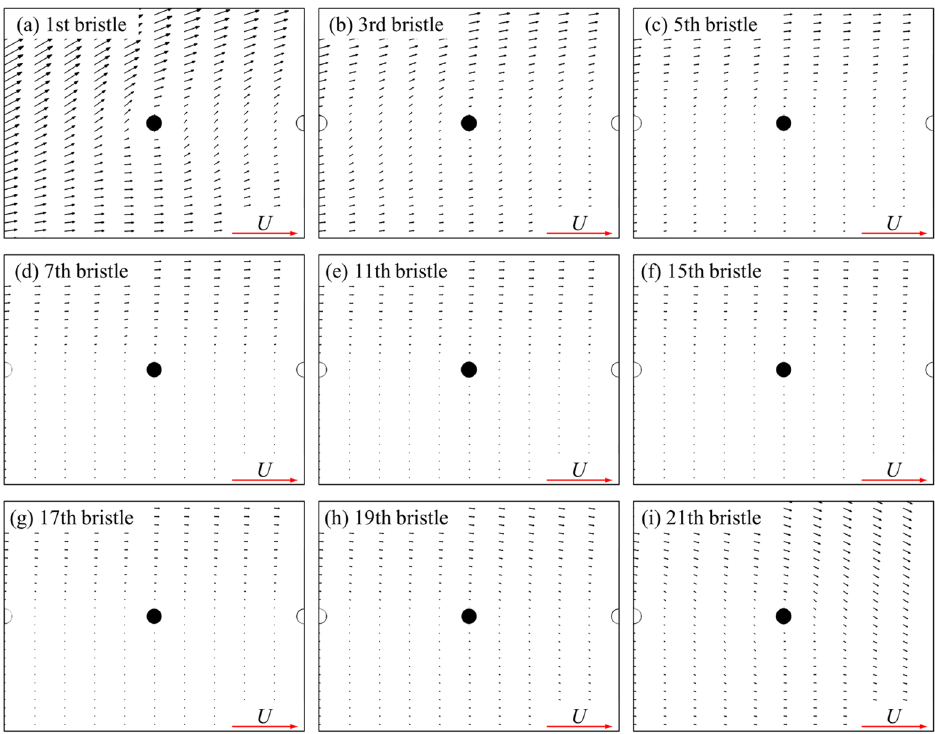
Figure 13. The plot of non-dimensional velocity vector around ( a ) the first, ( b ) the third, ( c ) the fifth, ( d ) the seventh, ( e ) the eleventh, ( f ) the fifteenth, ( g ) the seventeenth, ( h ) the nineteenth and ( i ) the twenty-first bristle of the upper one of two bristled wings.